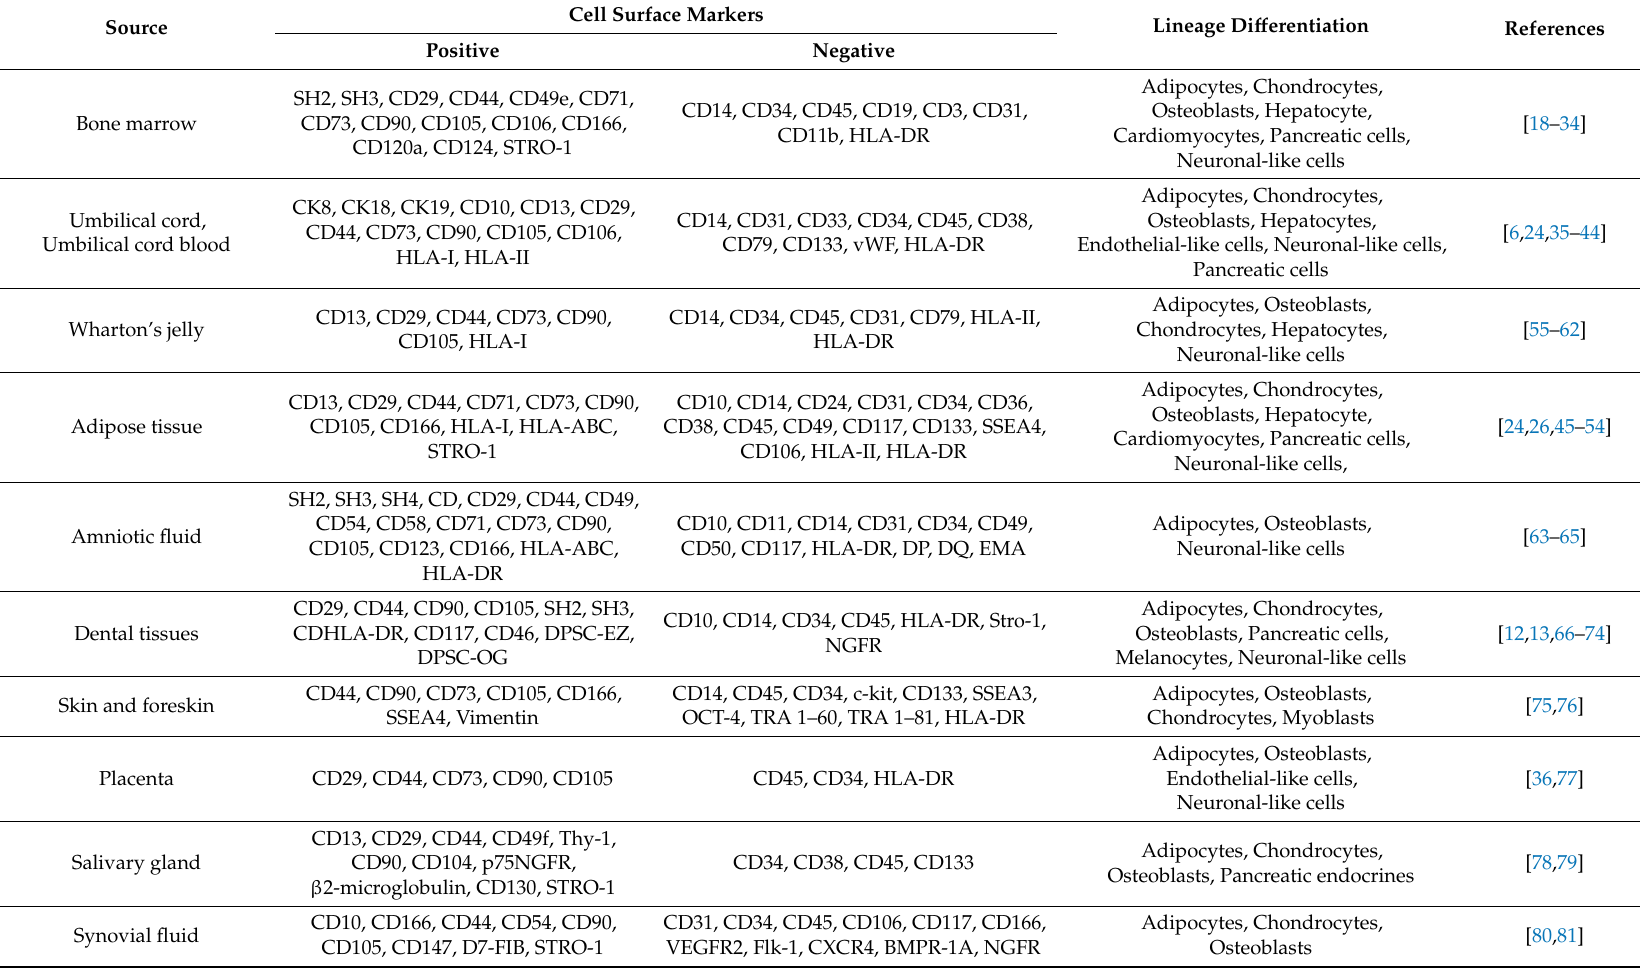
Table 1. Biological features of hMSCs from di ff erent sources, surface markers, and di ff erentiation